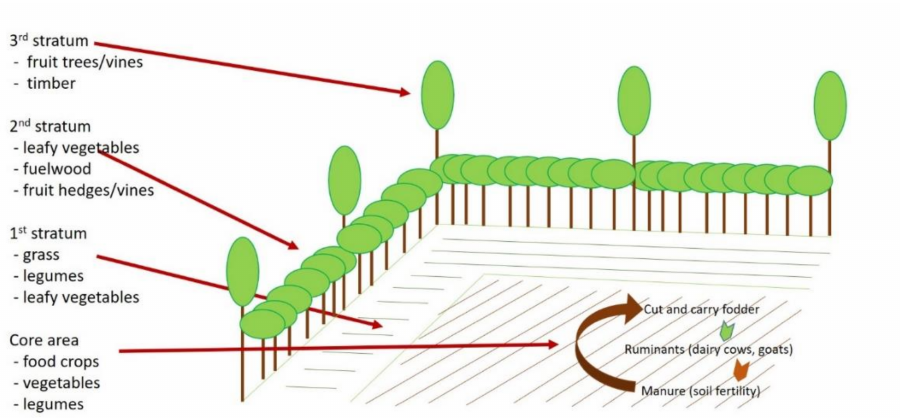
Figure 2. Three Strata Food System adapted from the Three Strata Forage System from Nitis et al. [30]. Image made by Thomas